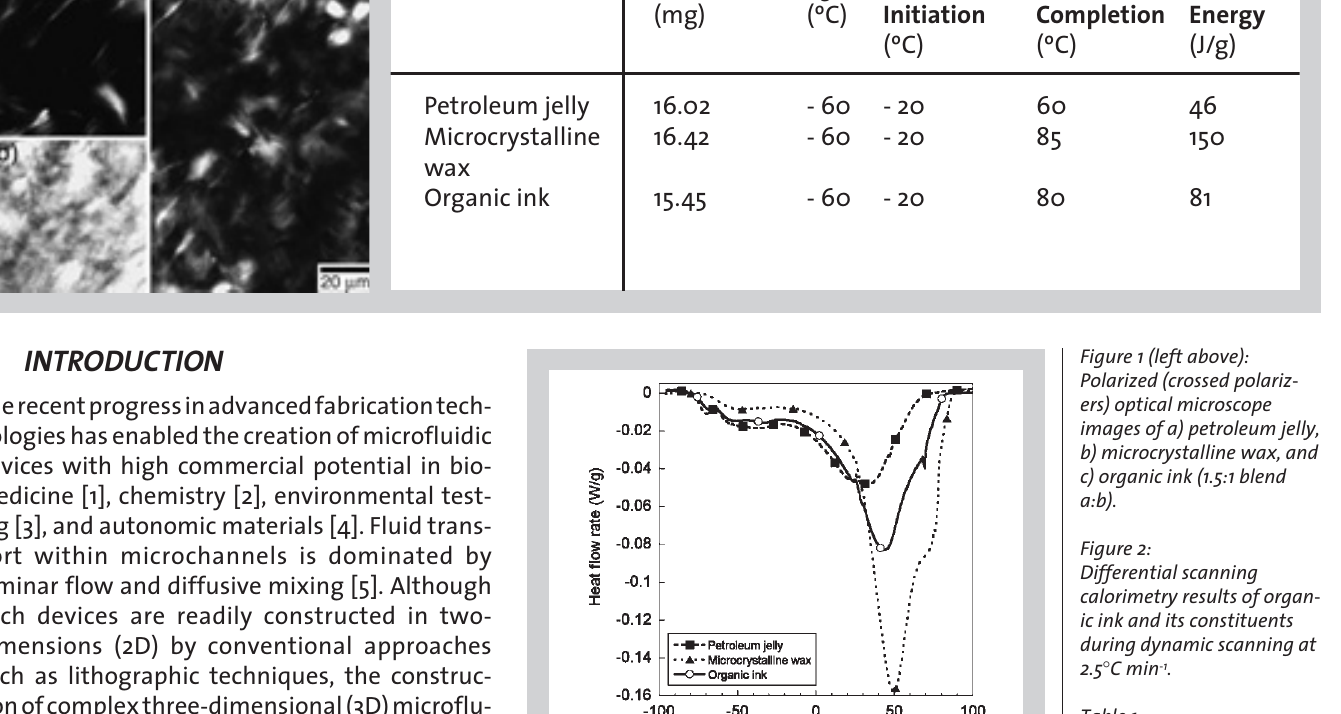
calorimetry results of organ- ic ink and its constituents during dynamic scanning at 2.5 ∞ C min -1 .